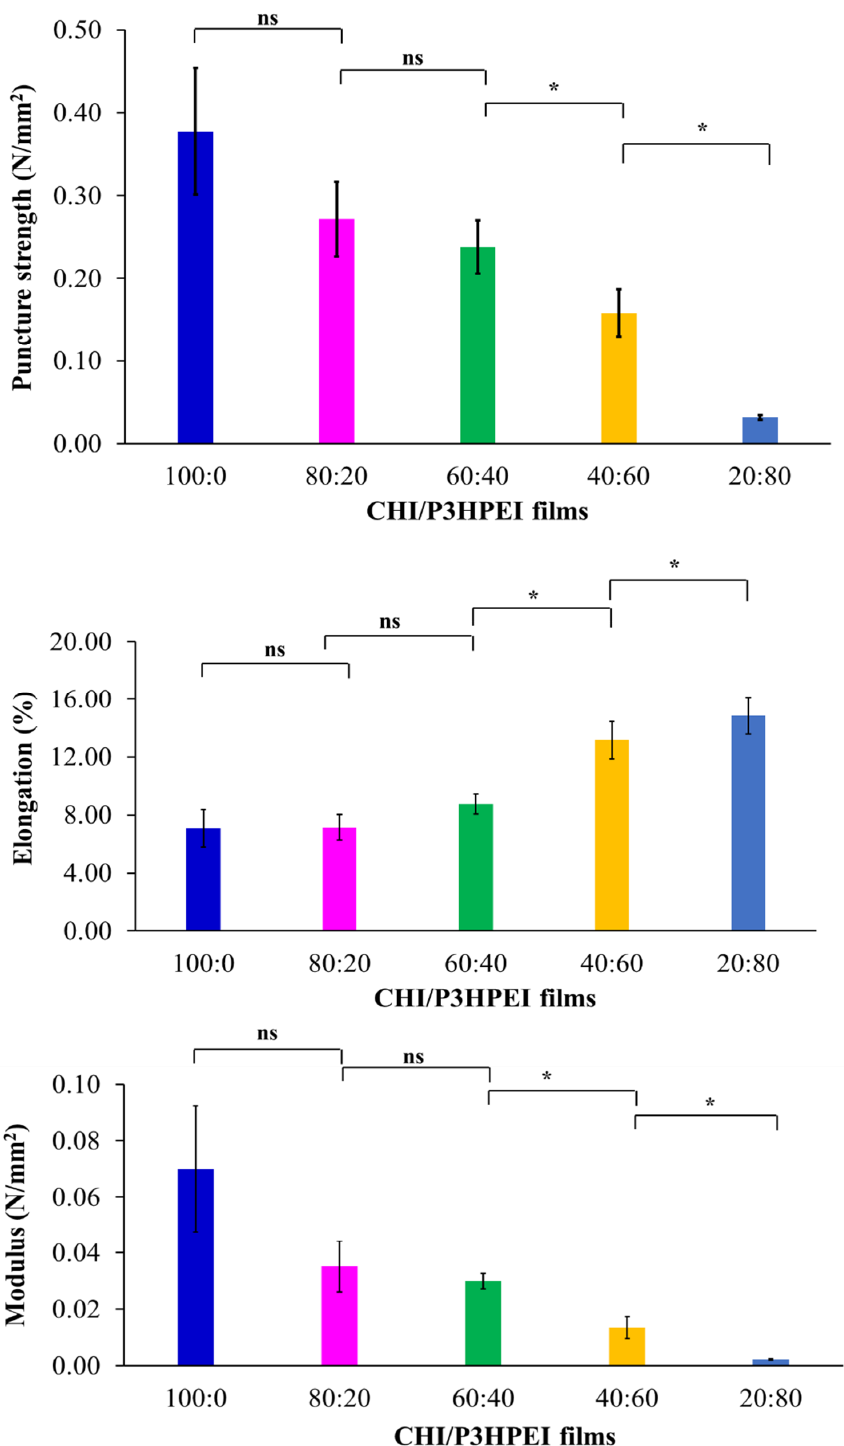
Figure 10. Mechanical properties of CHI and their blends with P3HPEI. Statistically significant dif- ferences are given as: *— p < 0.05; ns—no significance. differences are given as: *— p < 0.05; ns—no